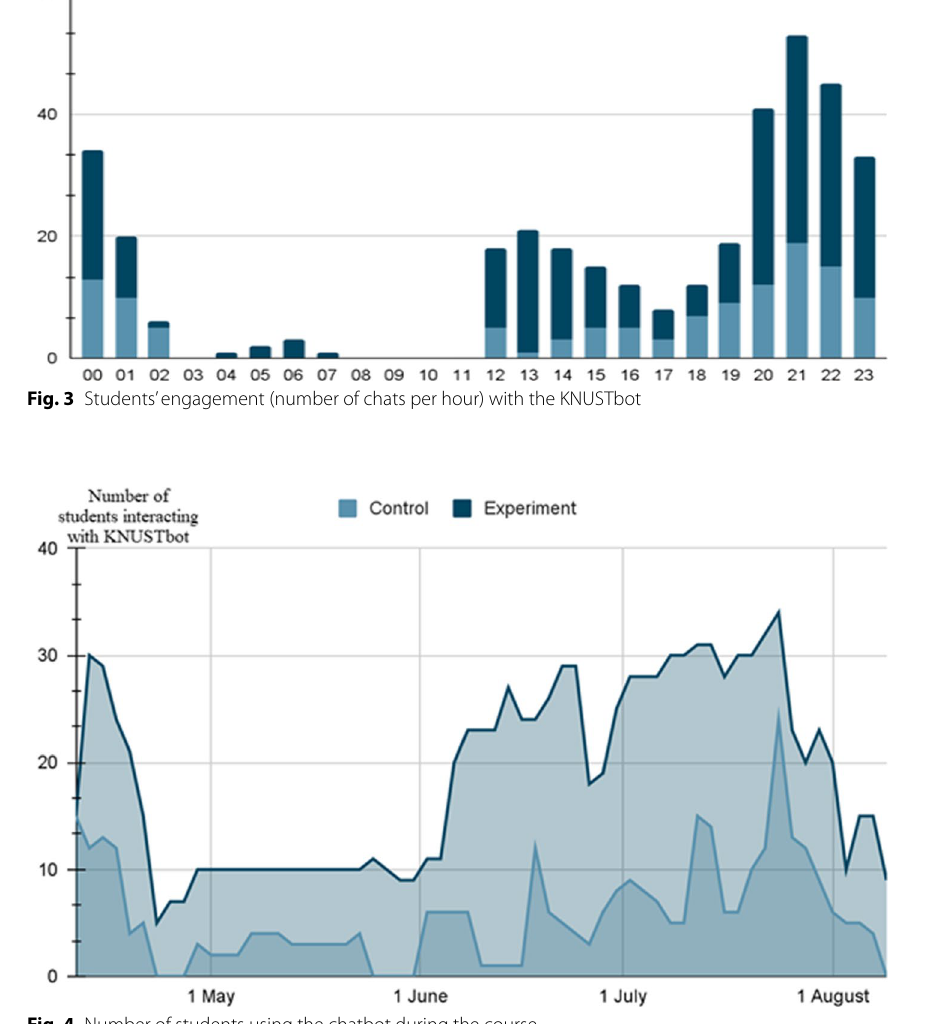
Fig. 4 Number of students using the chatbot during the